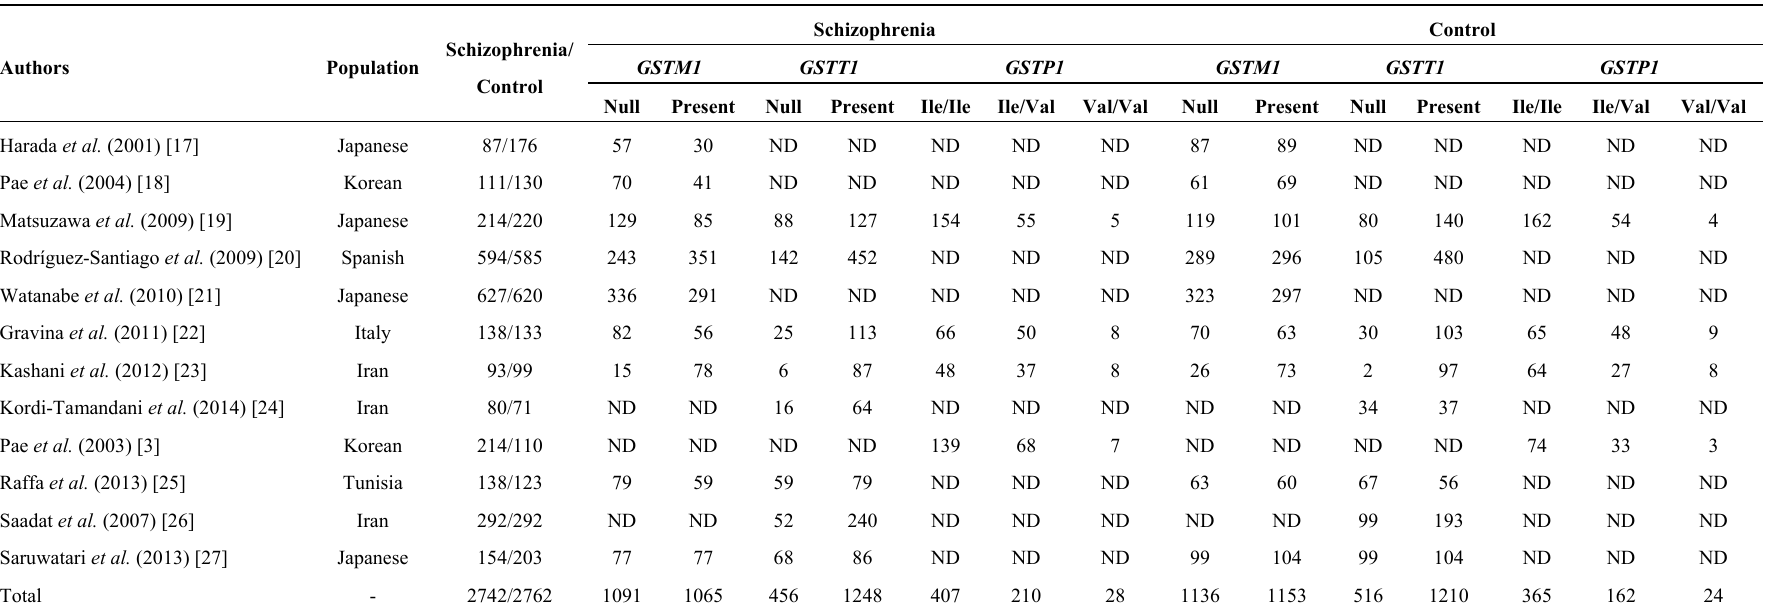
Table 1. Information of eligible studies included in the